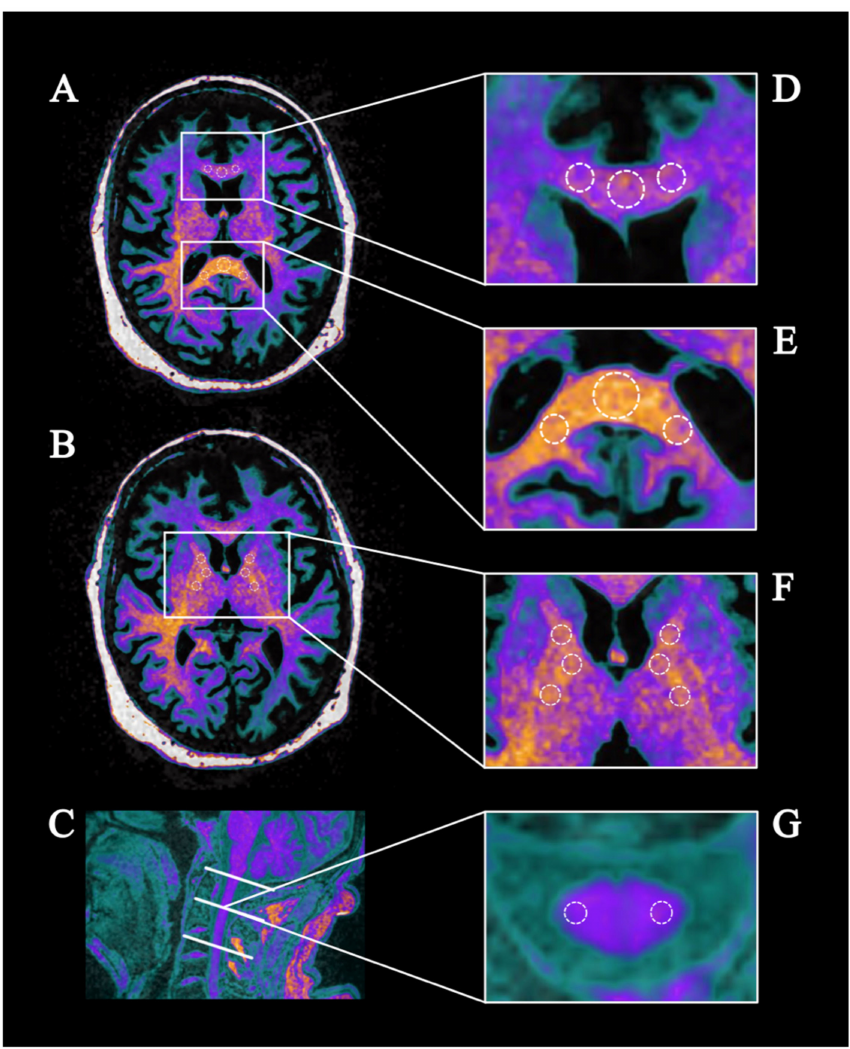
Figure 2. Regions of interest (ROIs) based analysis of the corpus callosum (A), capsula interna (B) and the cervical spinal cord (C) of HSP patients. In detail: ROIs in the rostrum (D) and splenium (E) of the corpus callosum, crus anterior, posterior and genu of the capsula interna (F) and the corticospinal tract of the cervical cord (G) at the level of the dens and the corpus of the second and third vertebral body